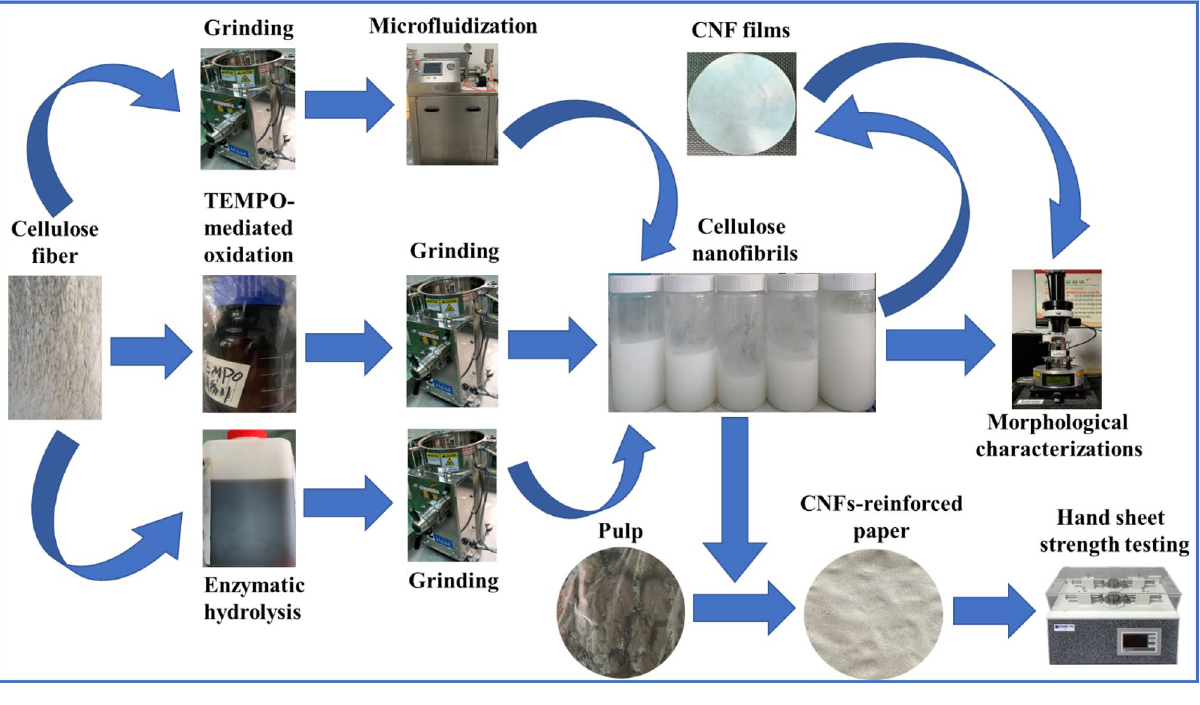
Figure 1. Scheme of detailed